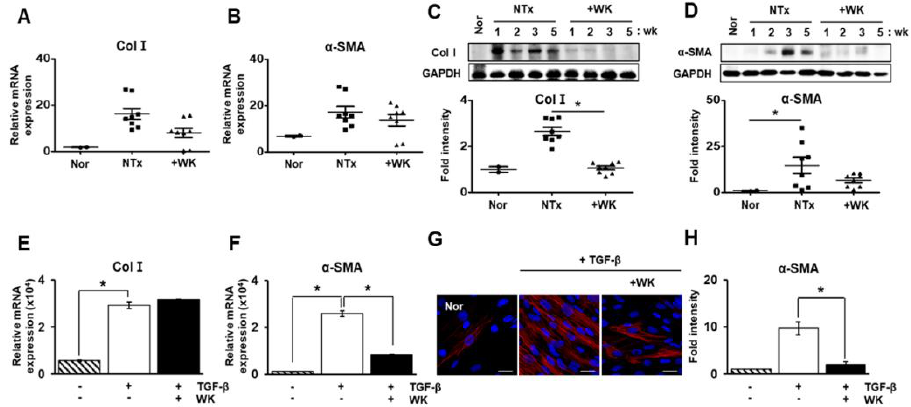
Figure 2. WKYMVm inhibits fibrogenic factor expression. The mRNA expression of Col I ( A ) and α-SMA ( B ) in the livers of normal, BDL, and WKYMVm-treated BDL rats was analyzed by qRT-PCR. Western blot analysis of Col I ( C ) and α-SMA ( D ) protein expression. The mRNA levels of Col I ( E ) and α-SMA ( F ) in TGF-β-treated HSCs were measured by qRT-PCR. ( G ) Immunofluorescence analysis of α-SMA in TGF-β-treated HSCs. Scale bar: 20 μm. ( H ) Staining intensity was quantified as the fold change. Mean ± SD ( n =3 per group),* p < 0.05; t-test or one-way ANOVA. Nor, normal control group; NTx, untreated BDL group; +WK, WKYMVm-treated BDL group; wk, week.